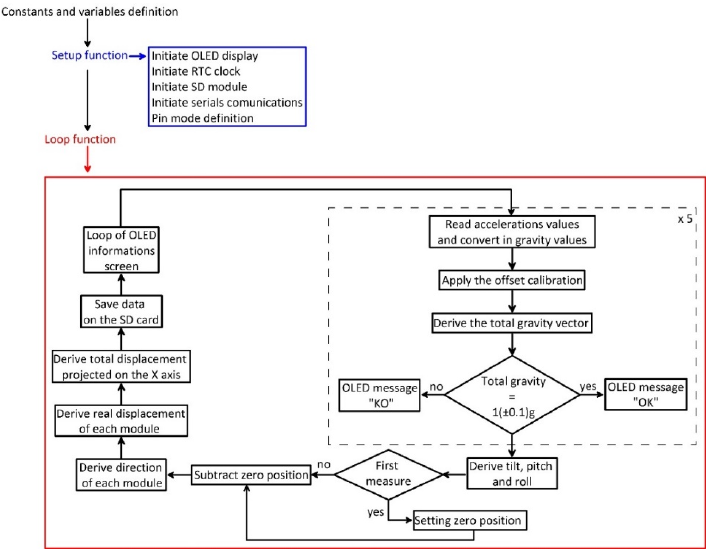
Figure 9. Flow chart showing the logic of the code of the master station.